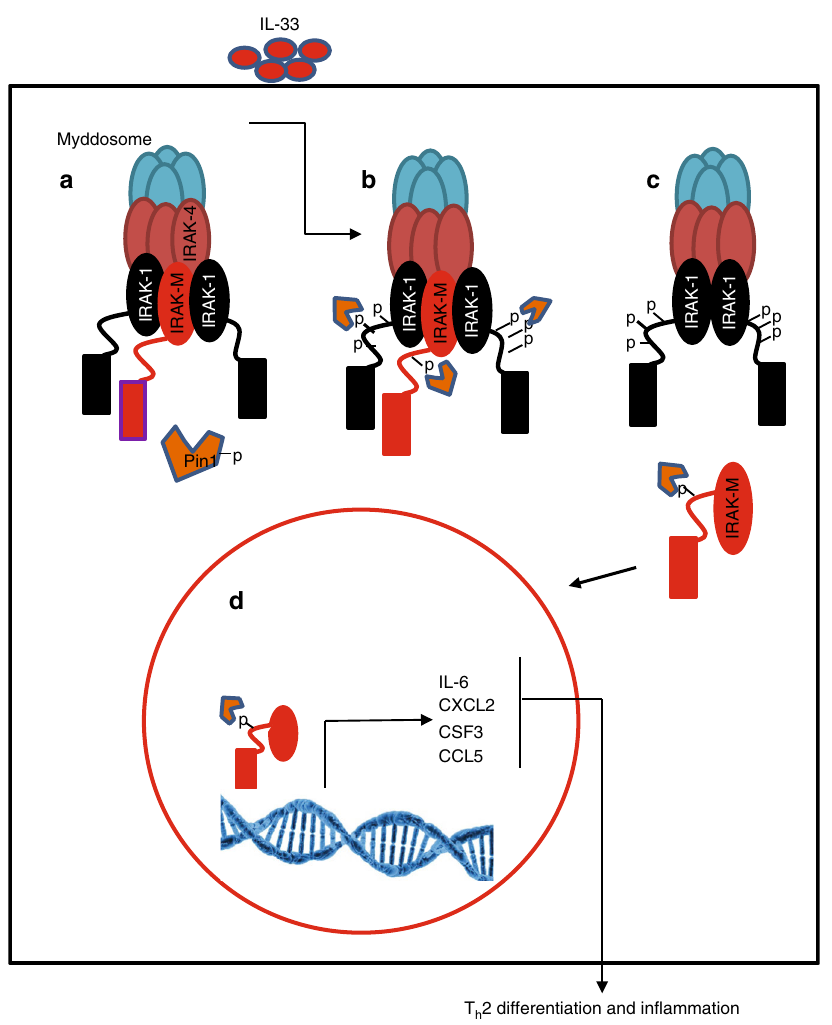
Fig. 8 Proposed model for IRAK-M activation mechanism by IRAK1 and PIN1, upon IL-33 stimulation. a IRAK-M is located in the Myddosome in association with IRAK1. PIN1 is phosphorylated at Ser71 and is inactive. b Upon IL-33 stimulation, IRAK1 is hyper phosphorylated and active and phosphorylates IRAK- M at S110P site. PIN1 is dephosphorylated and active. c PIN1 binds to IRAK-M phosphorylation site and induces conformational change that promotes its dissociation from the Myddosome. d Released IRAK-M translocates into the nucleus and induces the expression of its target genes for downstream T H 2 cell differentiation and in fl